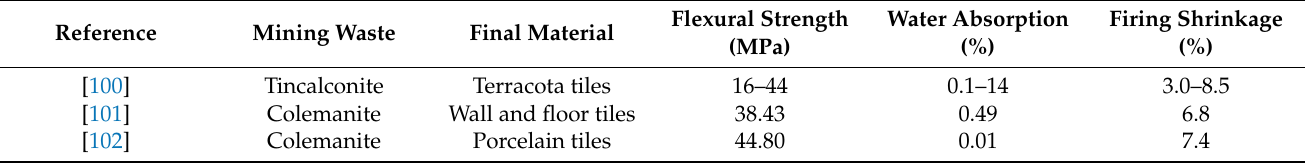
Table 9. Technological properties of mullite-based materials developed from boron mining